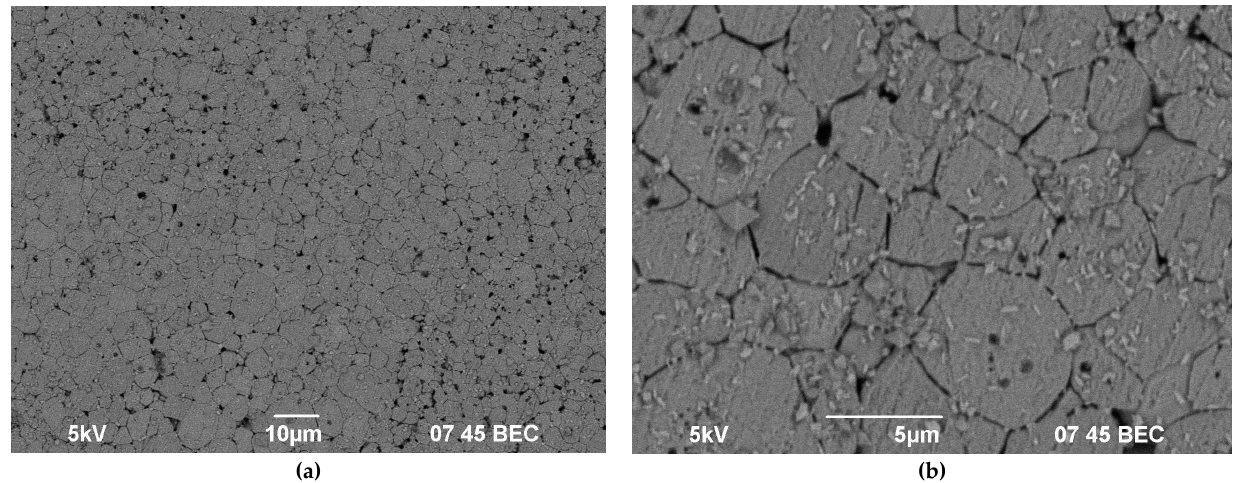
Figure 4. SEM images of a ceramic sample surface after hydrolytic tests for 1000 h at 300 °C. Figure 4. Surface of a ceramic sample after hydrolytic tests for 1000 h at a temperature of 300 ◦ C (magnification: ( a ) × 1000, ( b ) × 10,000).